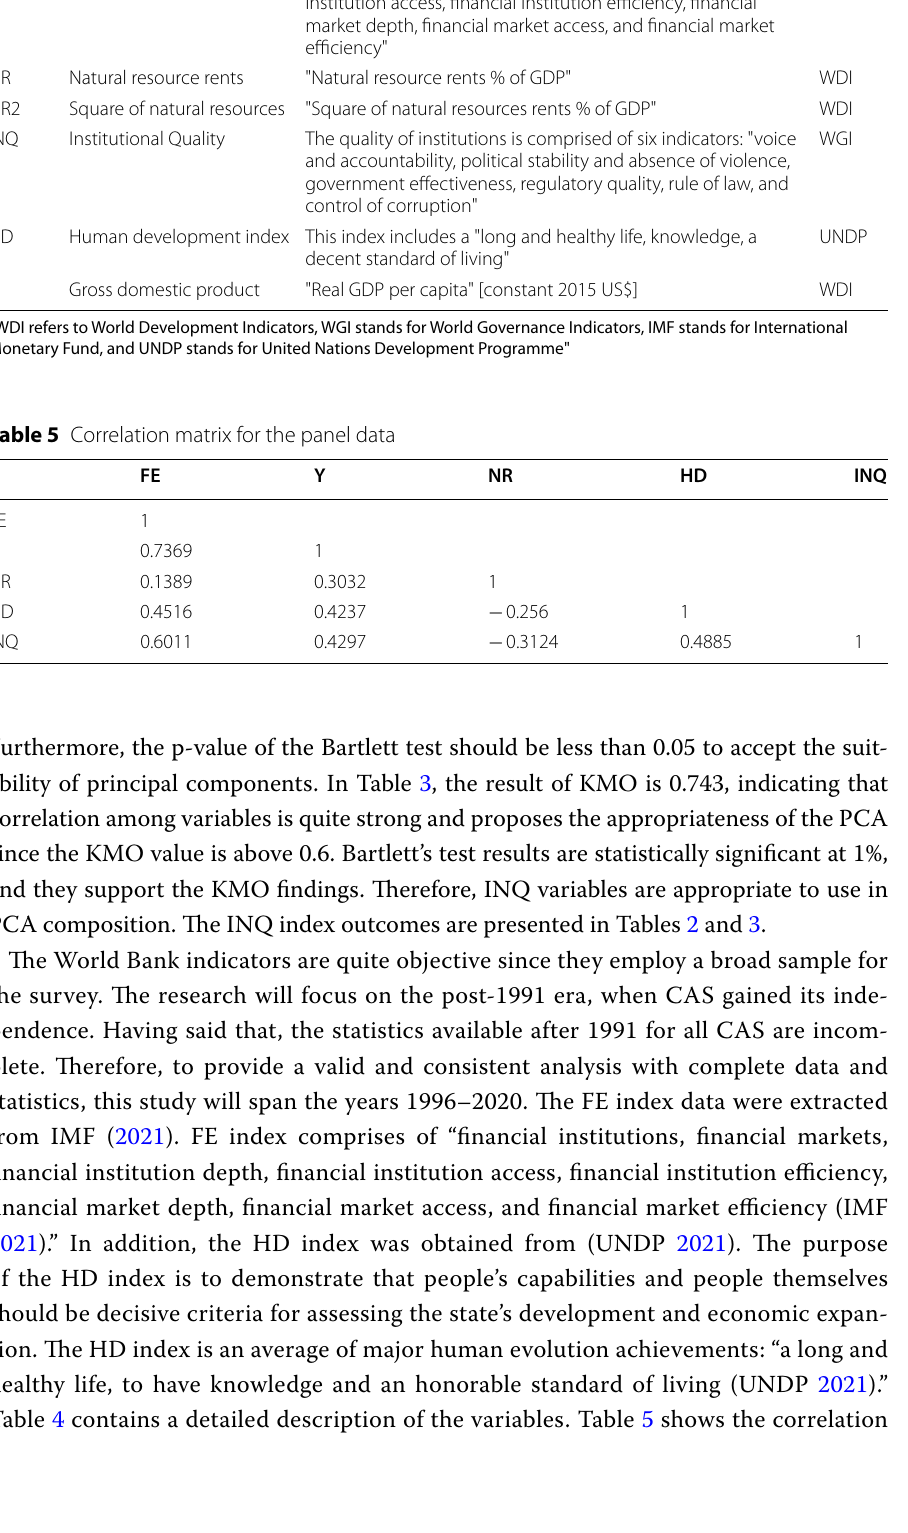
Table 4 Variables’ description